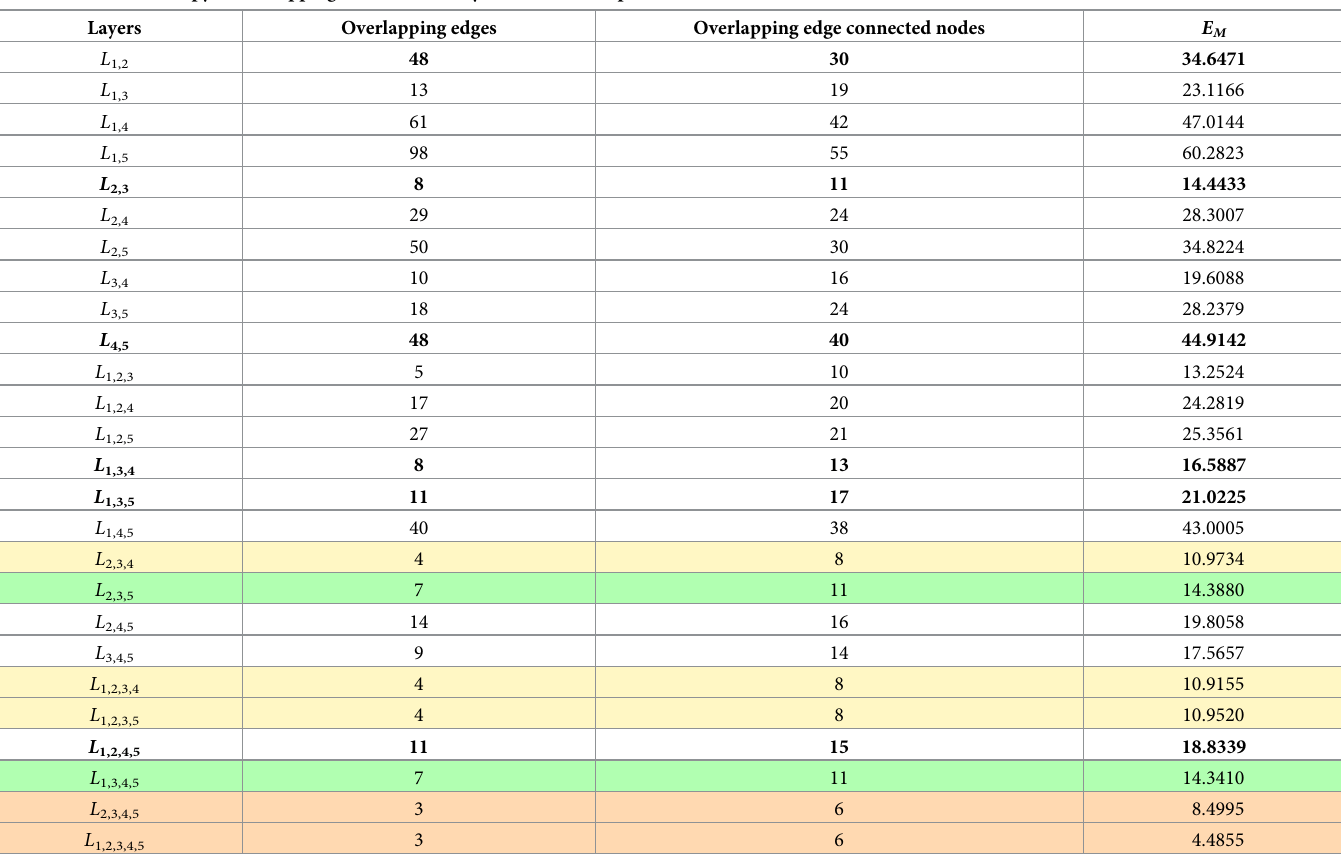
Table 3. Structure entropy of overlapping links between layers of aucs multiplex network.